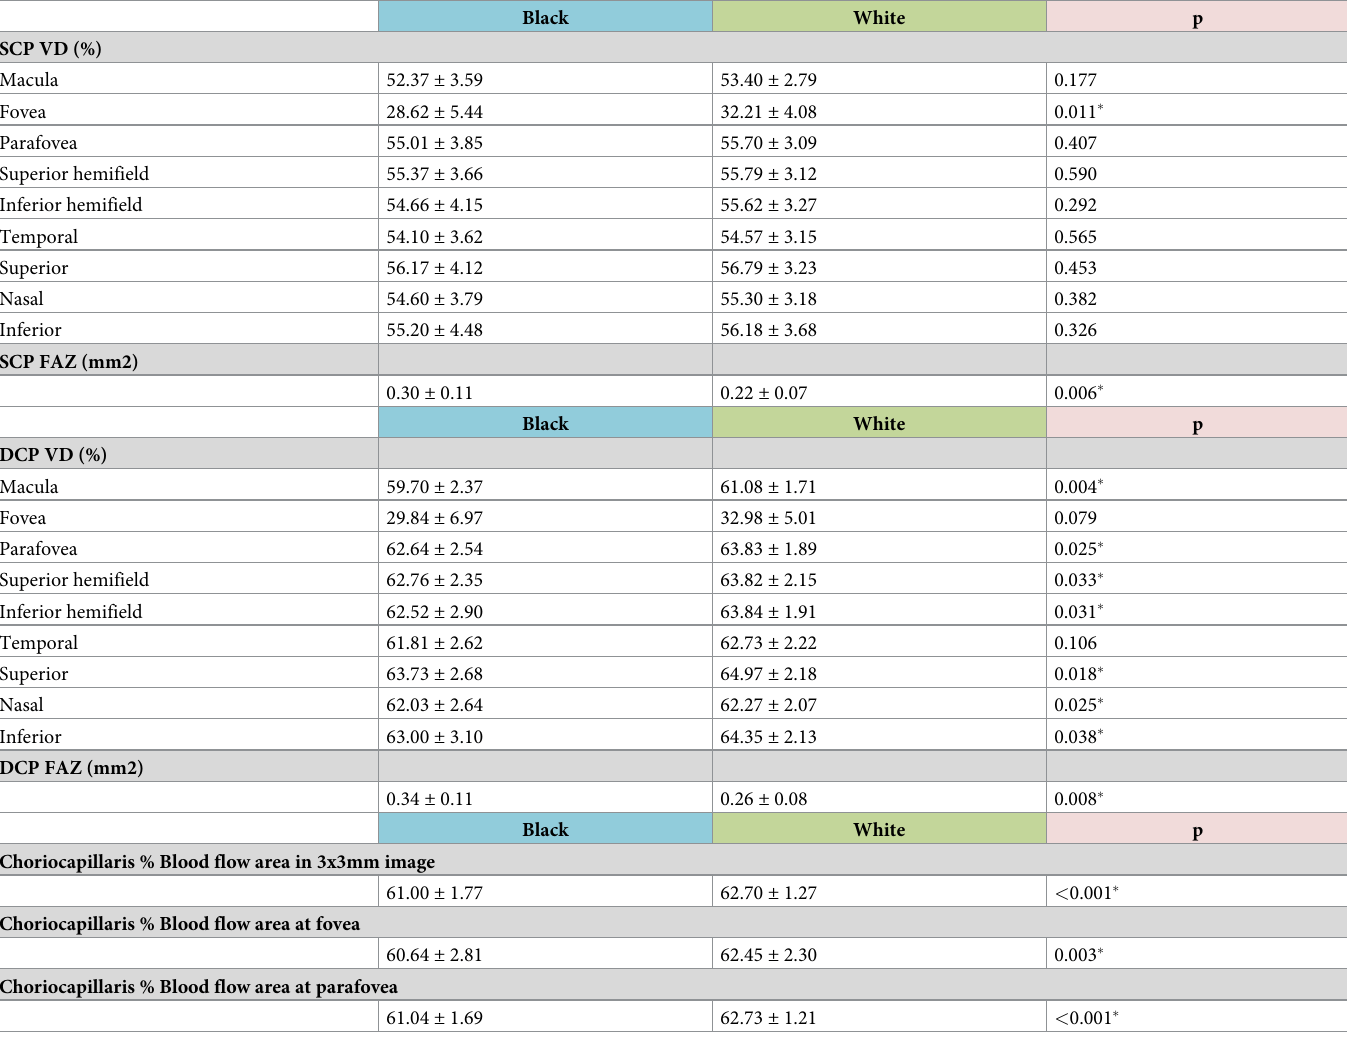
Table 2. VD, BFA, and FAZ in the SCP, DCP, and choriocapillaris for black and white subject